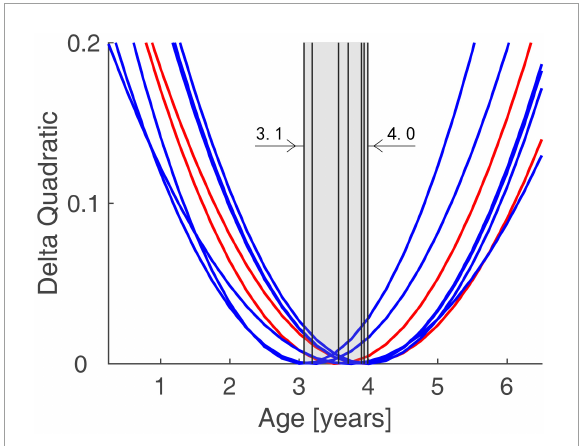
FIGURE3 Trends of Group Differences in terms of Functional Connectivity Trajectory. The difference between the trajectories of two groups formed a U-shaped curve with the age trajectory, with an inflection point at the age of